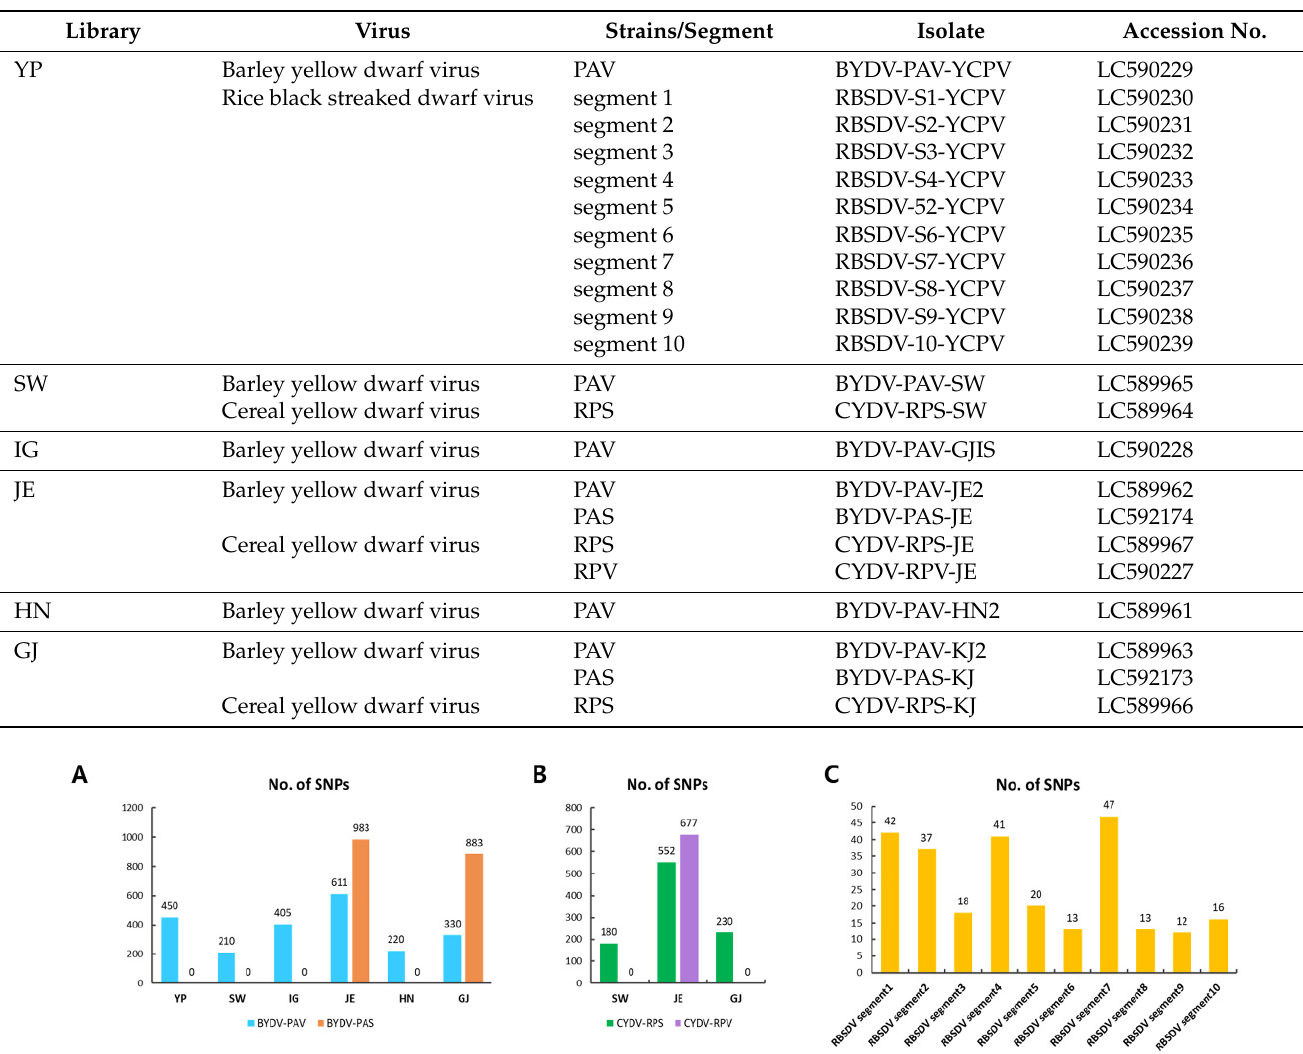
Table 3. List of identified viruses in six libraries in Korea.